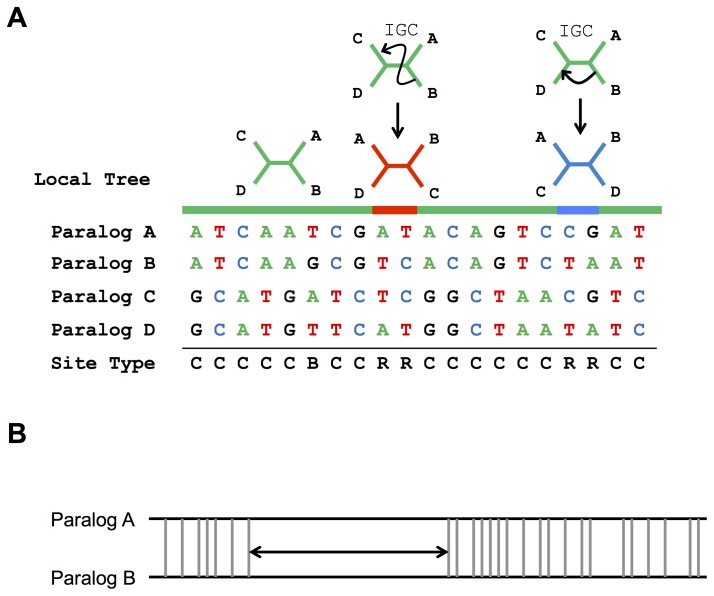
Methods for identifying historical IGC.(A) Local switches in tree topology can be driven by interlocus gene conversion (IGC). Bases at informative sites are shown for 4 paralogous sequences. The duplication history of these 4 sequences is captured by the unrooted green tree, which places paralogs A and B (C and D) as most closely related. Informative sites that are consistent with this topology are designated as concordant sites. Interlocus recombination can introduce sites that are discordant with this primary tree. Two interlocus gene conversion (IGC) events are illustrated, each giving rise to a small patch of reticulate sites supporting an alternative evolutionary relationship between paralogs (the red and blue trees). A third class of sites, bimutational sites, are sites of obligate double mutation at paralogous positions. (B) GENECONV scans paralog alignments to identify pairs of sequences with longer than expected tracks of perfect identity, conditioning the search on the overall pattern of variable sites in the alignment.